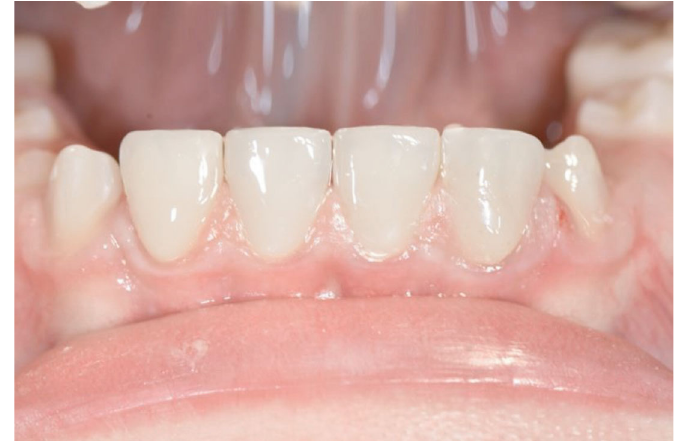
Figure 18: 6 months postoperative view of Edelweiss Veneers [31 –